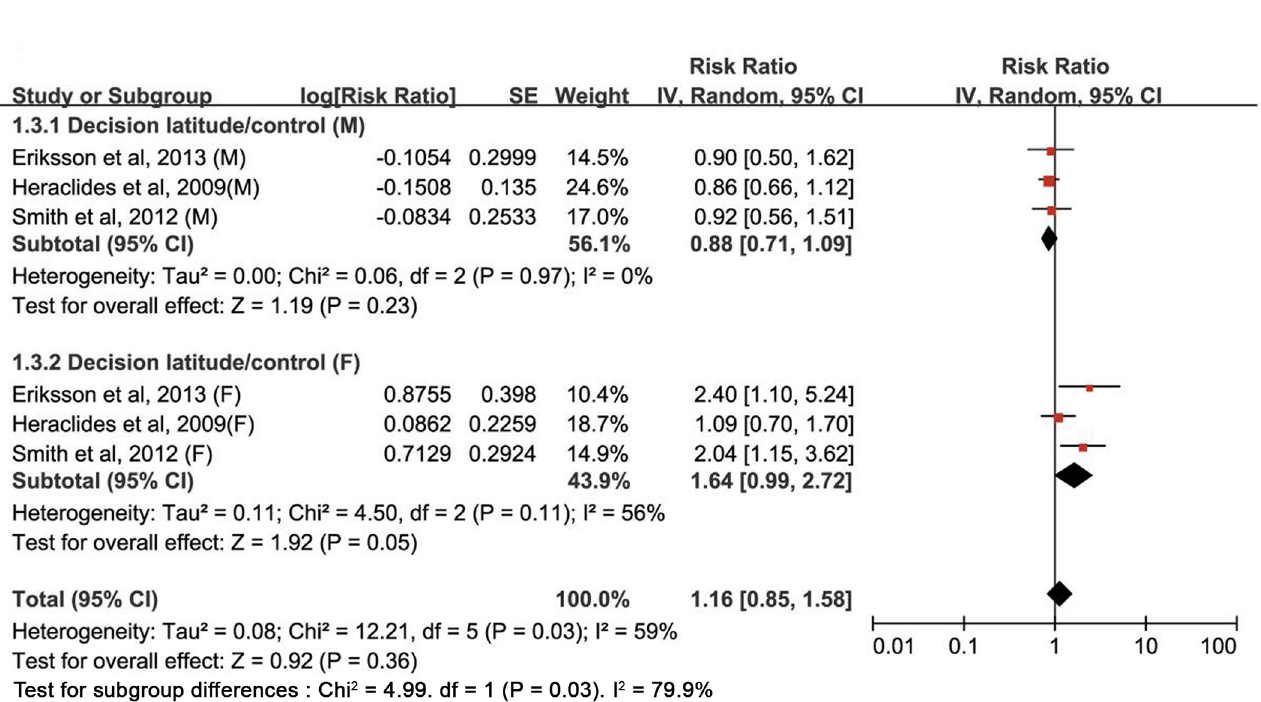
Fig 4. Estimates of type 2 diabetes associated with decision latitude/control in men and women. SE, standard error; CI, confidence interval; M, male; F, female.